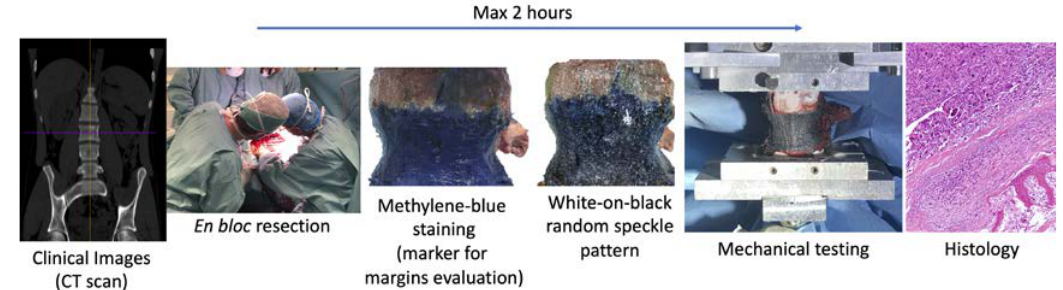
Figure 1. The workflow consisted of the CT-scan of the patient, en bloc resection of the vertebra with primary tumor, staining of the vertebra with methylene blue for the evaluation of the tumor margins, preparation of the white-on-black random speckle pattern for the DIC measurements, mechanical tests and histology. The time available between the resection of the vertebra and the end on the mechanical test was two hours for not jeopardizing the patient’s diagnosis.